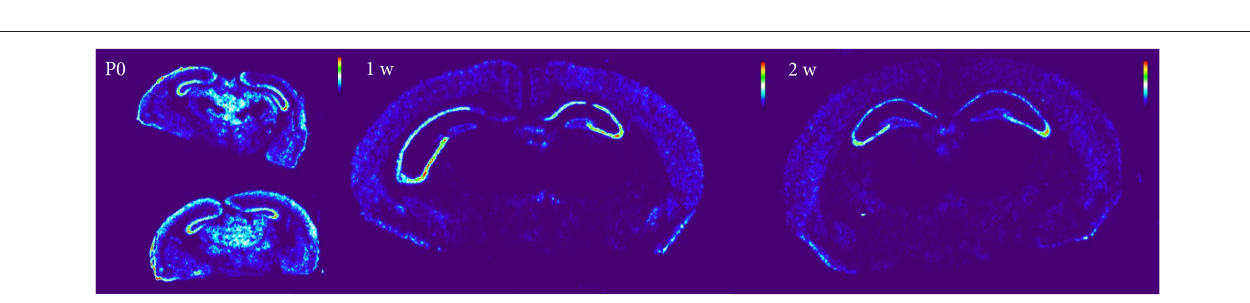
Nogo-Signaling Inhibitors: Olfactomedin, LgI1 and